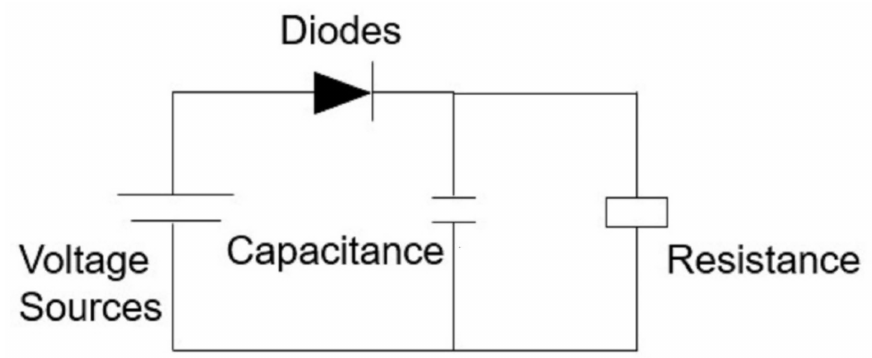
Figure 3. Working model of the envelope